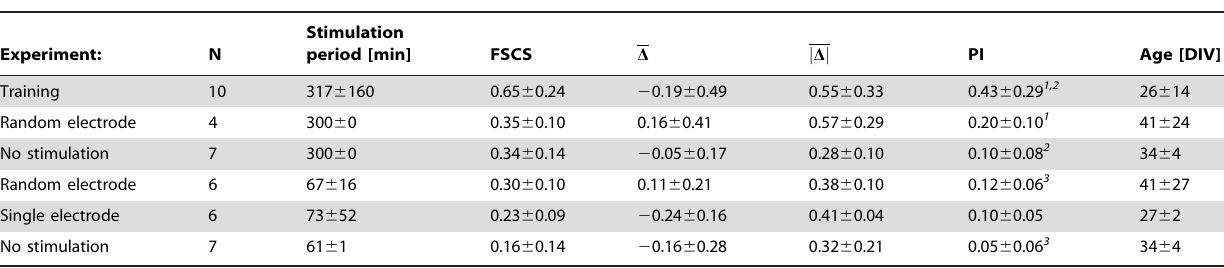
Table 1. Effects of various protocols on network connectivity.